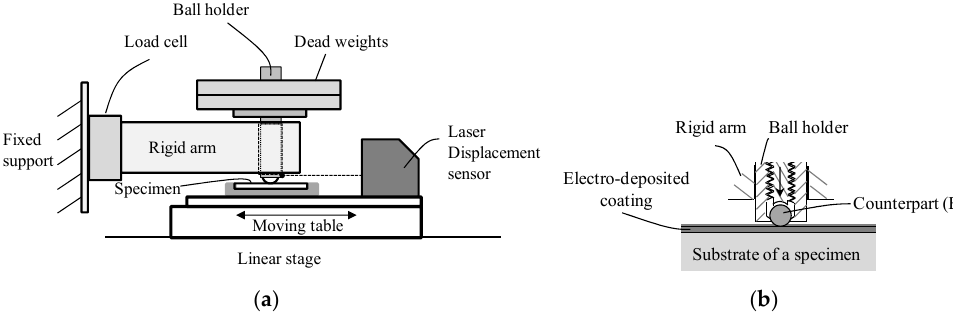
Figure 1. A schematic diagram of a fretting testing machine: ( a ) test rig; ( b ) ball ‐ on ‐ flat plate contact. Table 1. Condition of cathodic electro ‐ deposition.